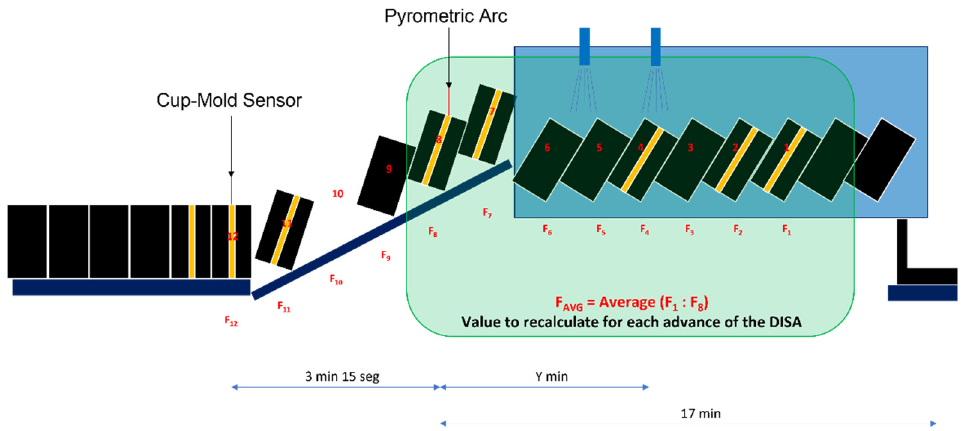
Figure 4. Mold sequence diagram in the digital twin and how 𝑛 = 25 molds are selected for the average weight calculation. average weight